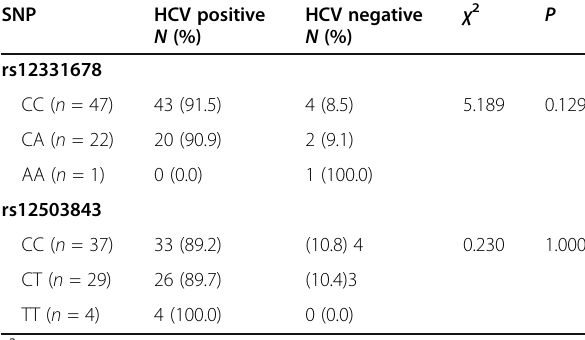
Table 3 Stratifications of rs12331678 and rs12503843 in correlation to HCV carrier status in HCC group ( N = 70)